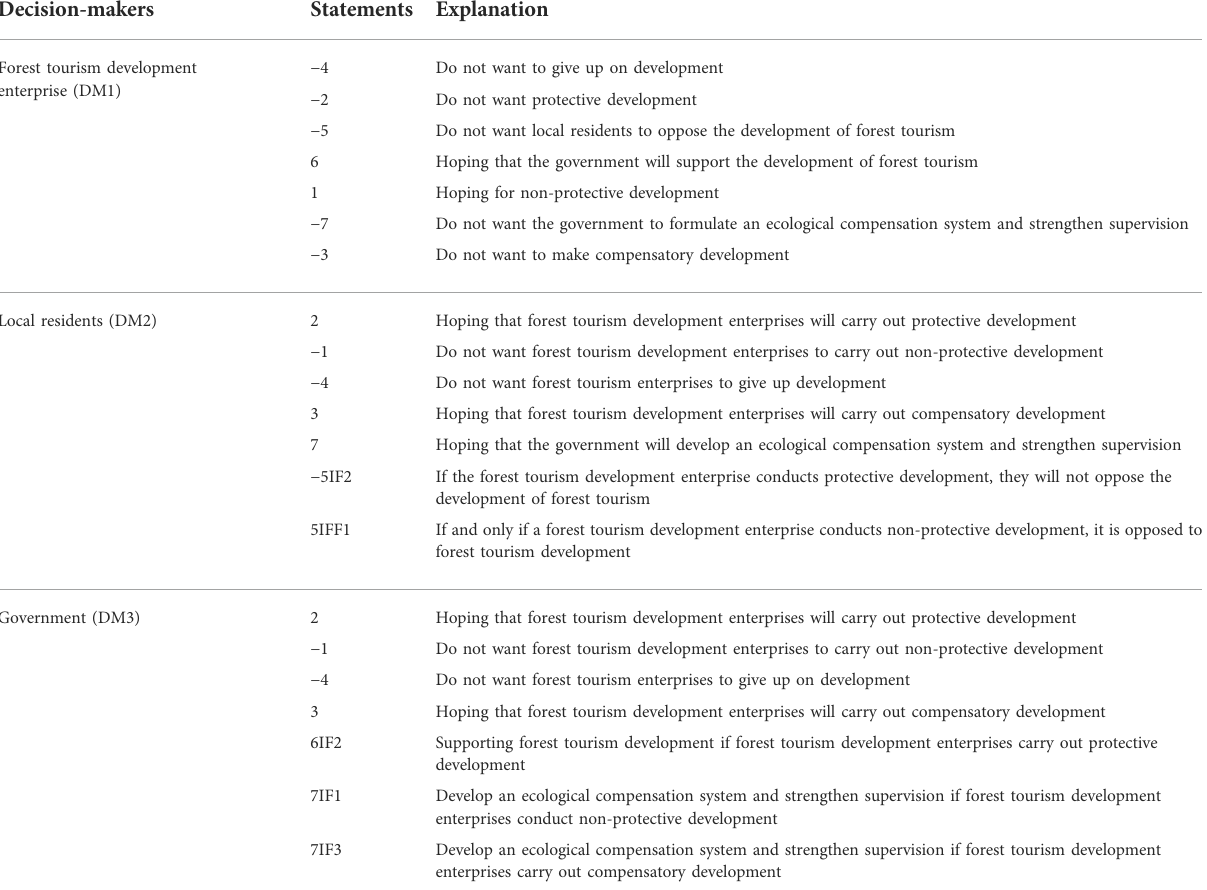
TABLE 2 Preference statements and implications of decision-makers in forest tourism